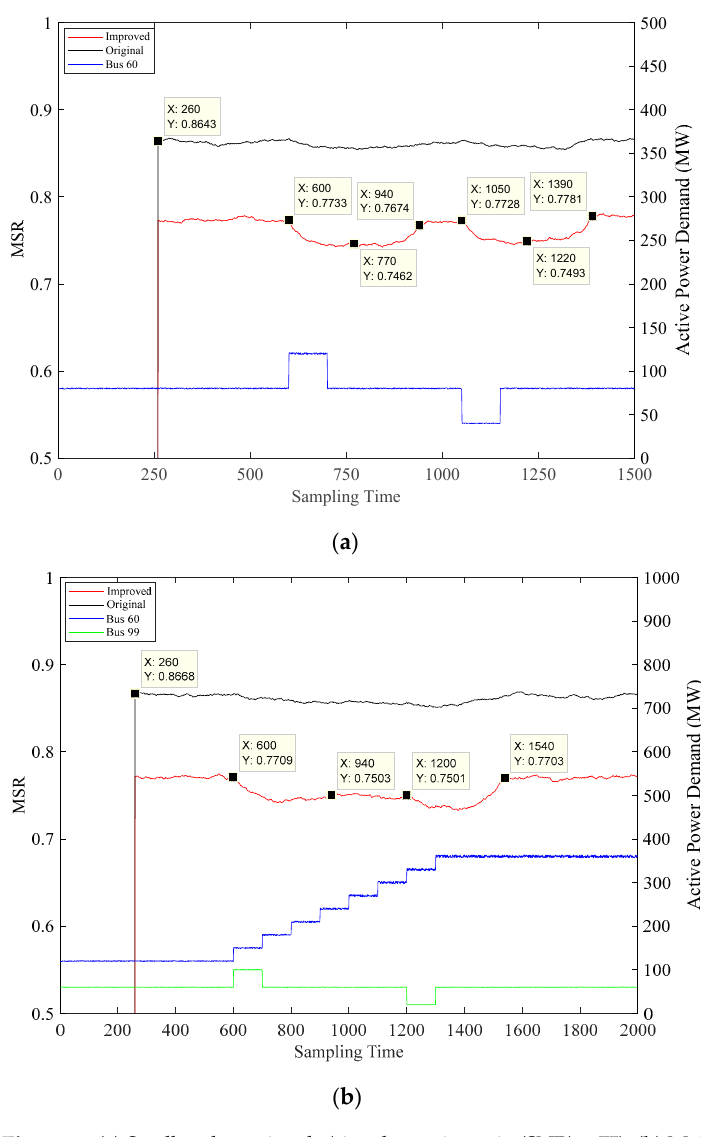
Figure 1. ( a ) Swell and sag signals (signal-to-noise ratio (SNR) = 75), ( b ) Multiple signals (SNR = 70), mean spectral radius (MSR)- t curves of the improved and original event detectors in the situation with heavy noise [30]. (Reproduced with permission from Fujia Han, IEEE Proceedings; published by IEEE, 2018.) Apart from single signals, multiple signals can be also discovered by the improved